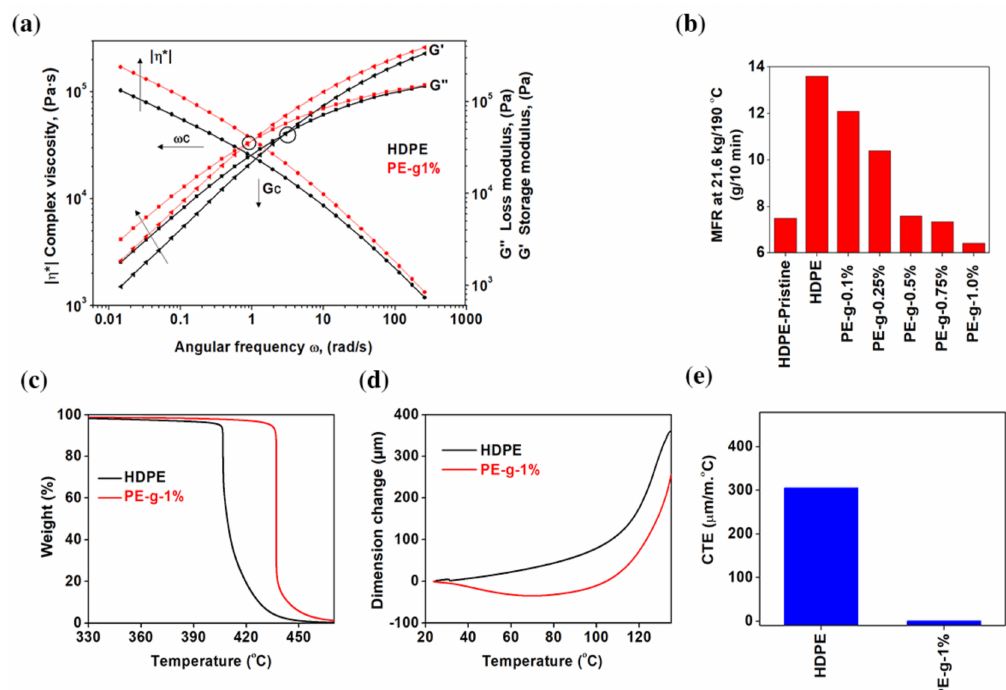
Figure 6. Thermal stability performance and rheological behaviors. ( a ) Dynamic frequency sweep measurements performed at 190 ◦ C. ω C is the crossover frequency point and G C is the crossover modulus point in a log–log scale. ( b ) Melt flow rate (MFR) measurements of PE-g nanocomposites as a function of graphene loading (0.1, 0.25, 0.5, 0.75, and 1.0 wt.%). ( c ) Thermogravimetric thermograms performed in N 2 atmosphere. ( d ) Dimensional change as a function of temperature. ( e ) Coefficient of thermal expansion (CTE) measured at temperature difference range of 30-105 ◦